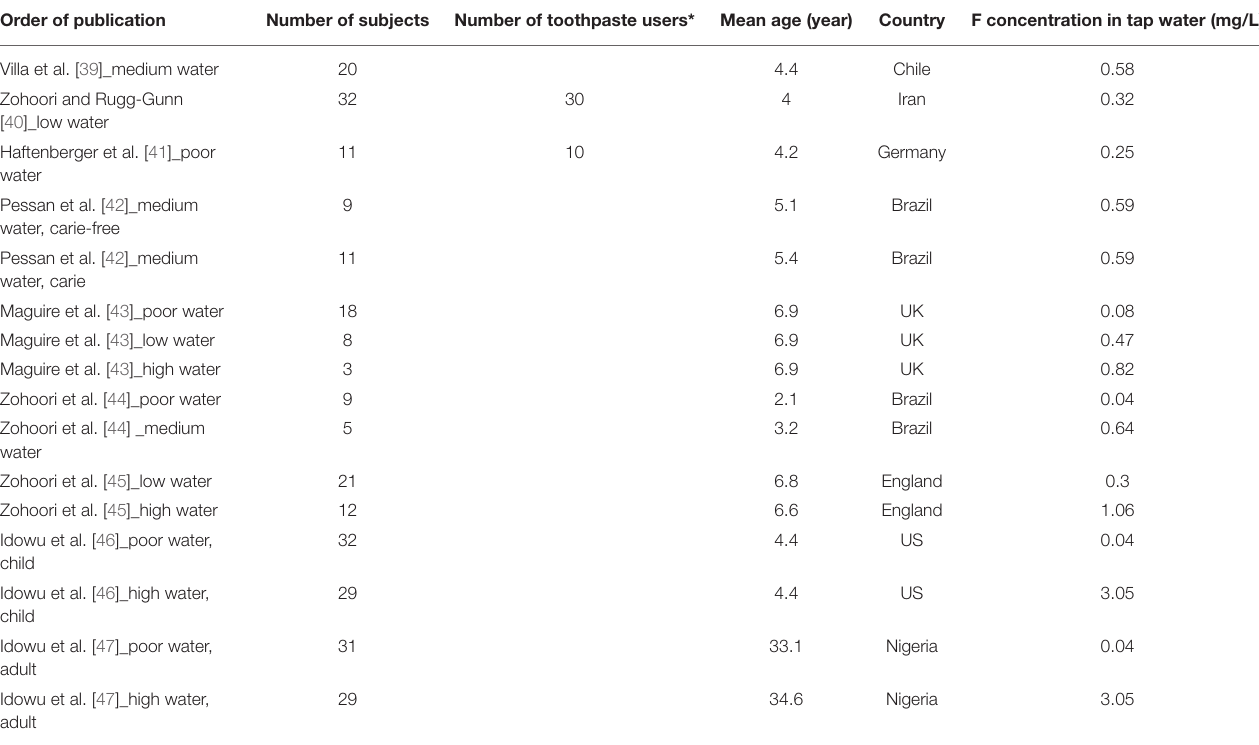
TABLE 2 | Number of participants, their mean age and country of residence, with the associated F concentration in tap water (mg/L) in articles regarding estimated F intake and urine monitoring in our Excel database. Order of